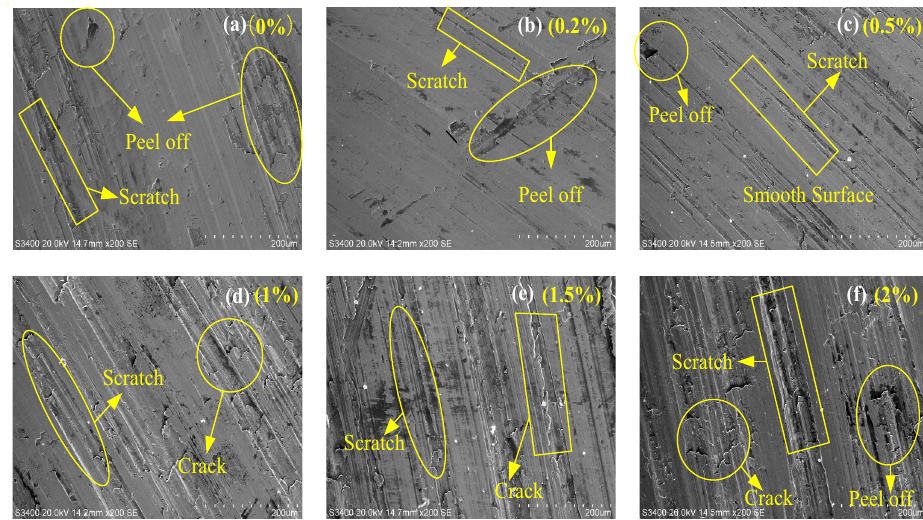
Figure 5 Surface morphology under different nanoparticle